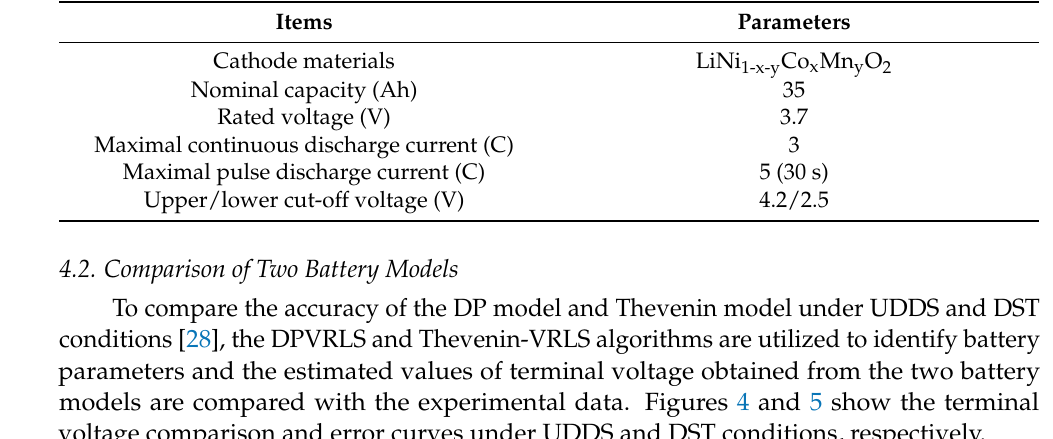
Table 3. Technical parameters of the battery.